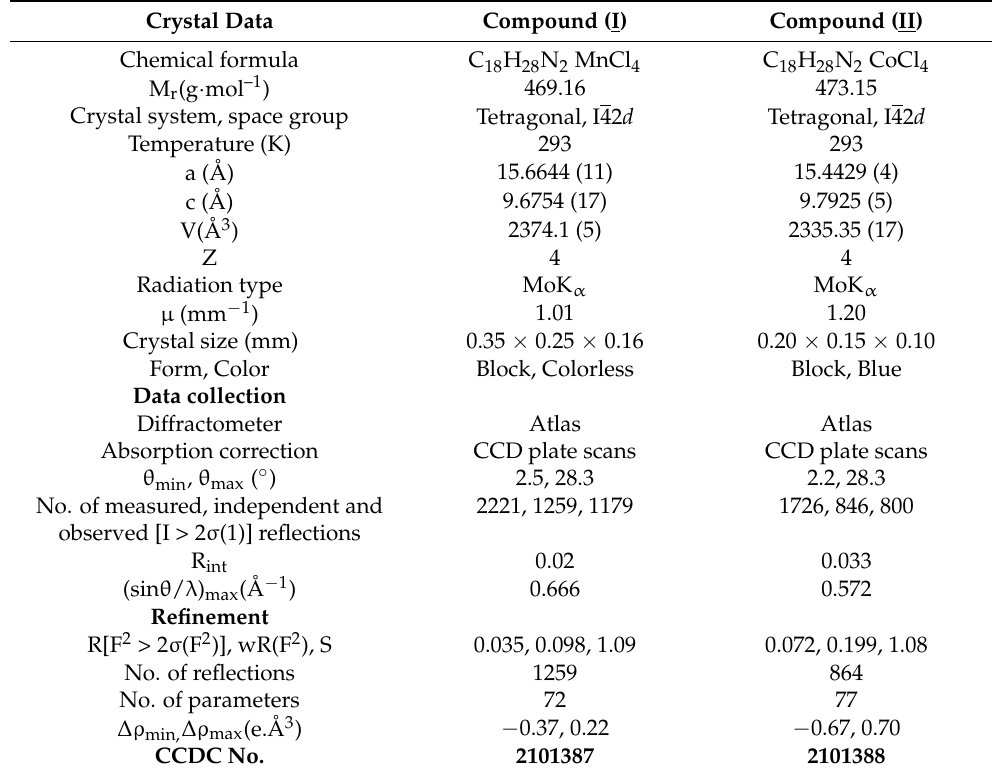
Table 1. Experimental